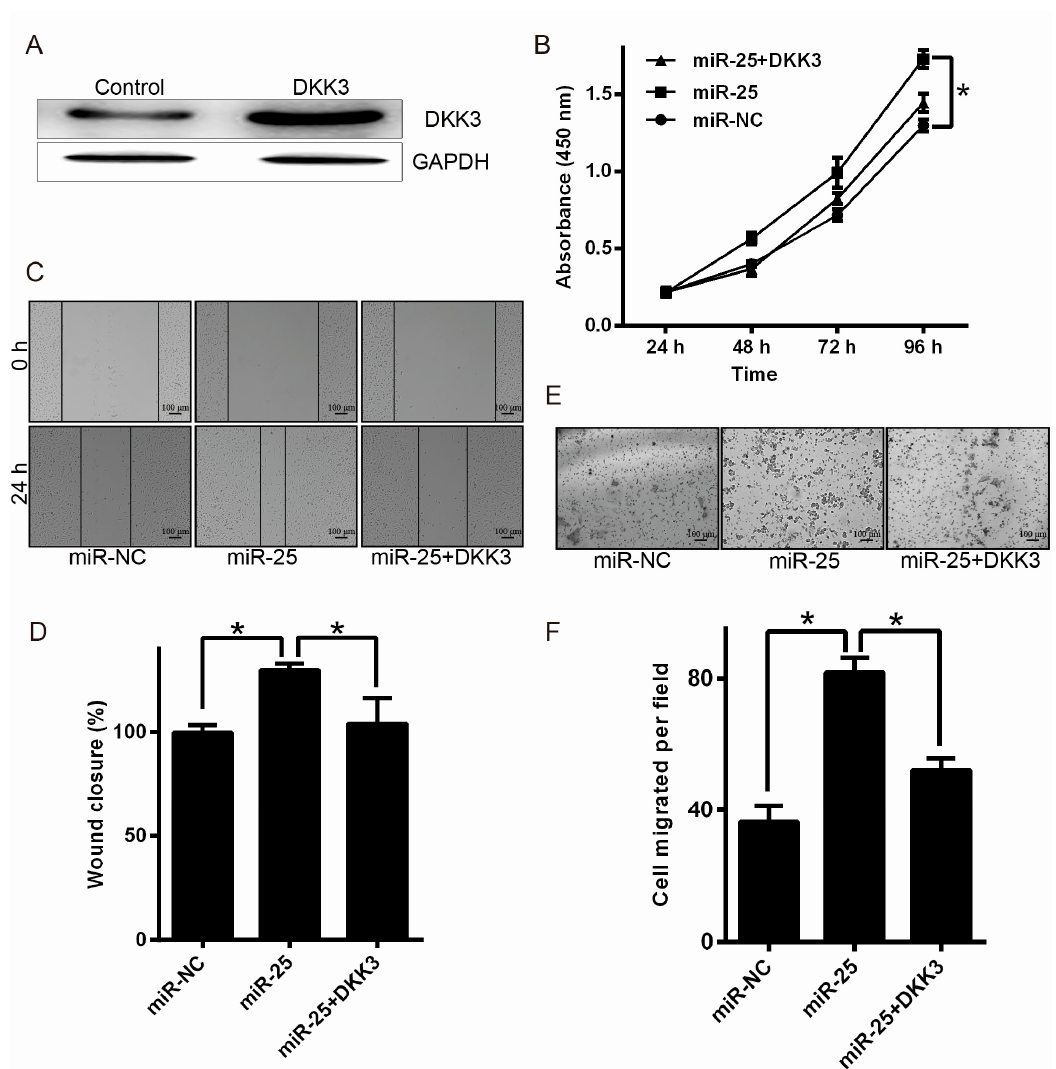
Figure 4. Overexpression of DKK3 attenuates the oncogenic influence of miR-25 in part. ( A ) MV3 were transfected with pcDNA3.1-DKK3 or control vector, and the protein levels of DKK3 were detected by Western blot analysis; ( B ) MV3 were co-transfected with miR-25 and pcDNA3.1-DKK3 vector or control, and the proliferation of MV3 was tested by the MTT assay; ( C , D ) MV3 motility of pretreated cells were measured by wound-healing assays; ( E , F ) pretreated MV3 motility was measured by transwell assays. Data are expressed as the mean ± SD of three independent experiments. * p < 0.05. Scale bar = 100 μ m.